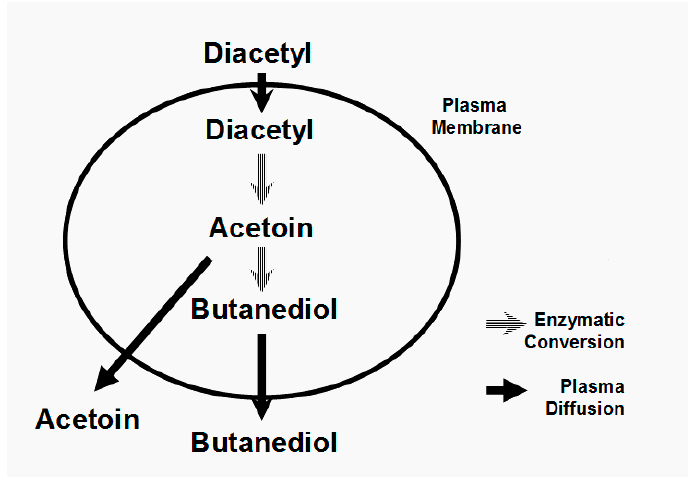
Figure 14. Reduction of diacetyl to acetoin and 2,3-butanediol.